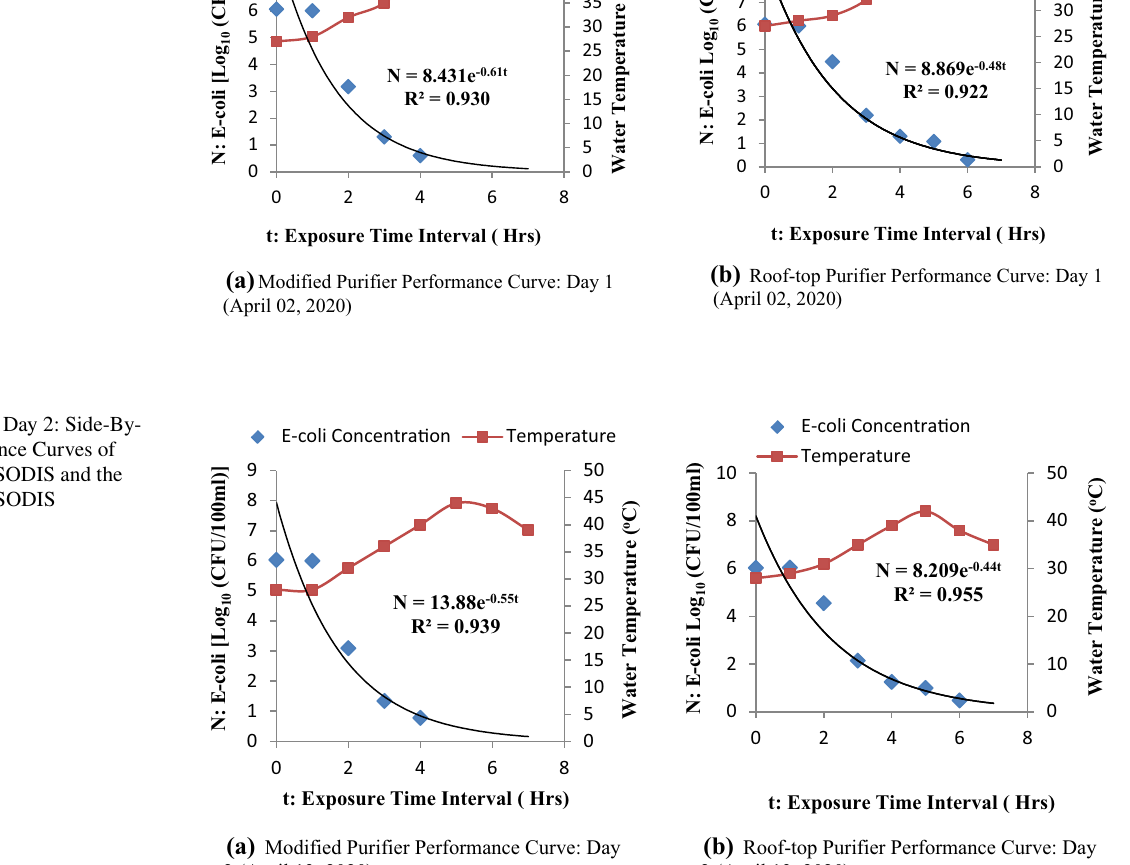
Fig. 8 a and b Day 1: Side-By- Side Performance Curves of the Improved SODIS and the Conventional SODIS